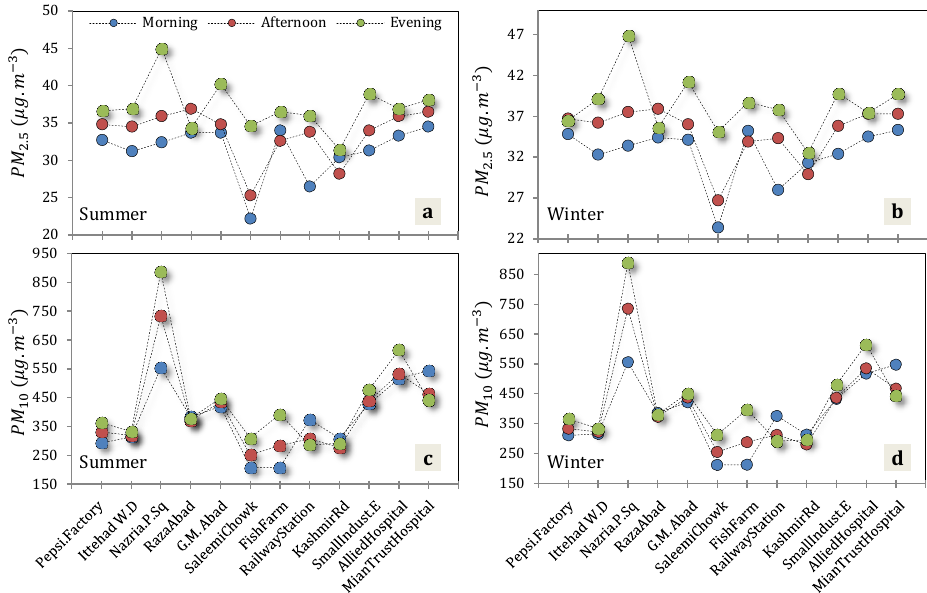
Figure 9. A comparison between mean values of PM 2.5 and PM 10 data with respect to the daytime (morning, afternoon, evening) and season (summer or winter) in the 12 locations for ( a ): PM 2.5 in summer, ( b ): PM 2.5 in winter, ( c ) PM 10 in summer, ( d ) PM 10 in winter.